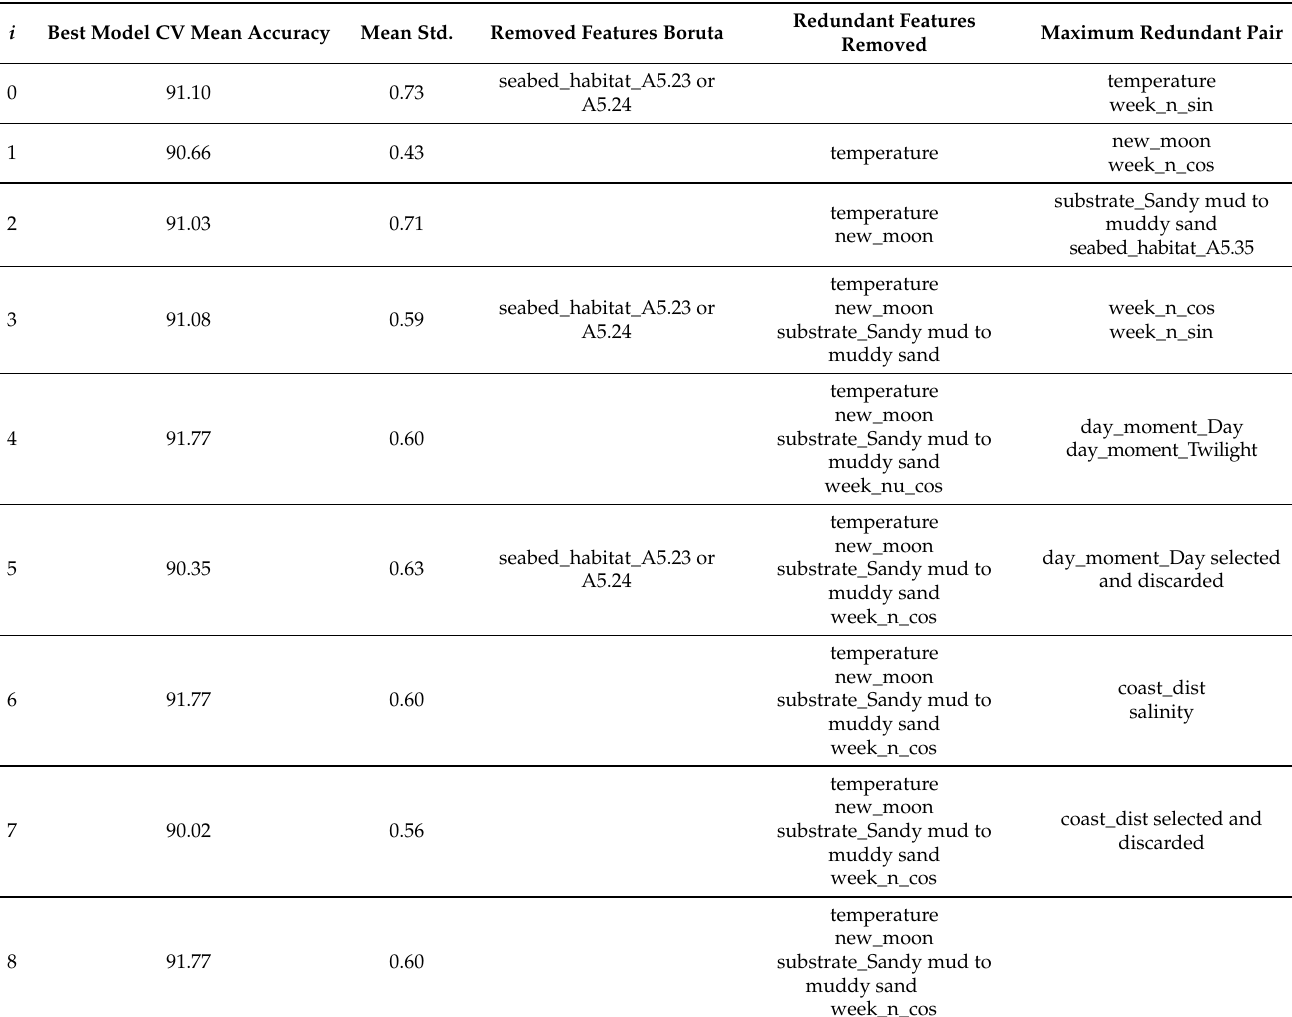
Table 2. Summary of the selected model at each iteration, and their performance with the consequent redundant pairs and the features